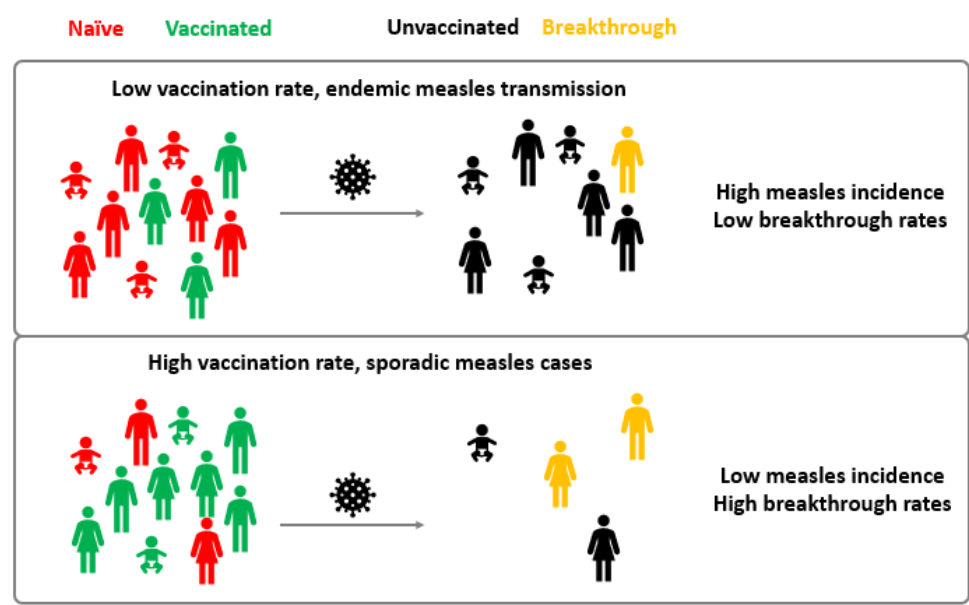
Figure 1. Measles breakthrough cases in countries with endemic or sporadic measles transmission. In populations where the majority of individuals are naïve, MV can circulate endemically and most of the infected individuals will be unvaccinated subjects ( top ). On the other hand, in populations with high vaccination coverages (and lower MV circulation), the number of vaccination failure cases among susceptible individuals will be higher and so will be the proportion of breakthrough cases ( bottom ).